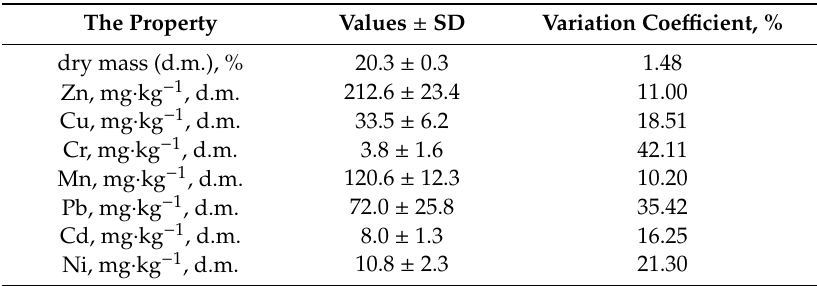
Table 1. Average raw sewage sludge properties ( ± SD, N =